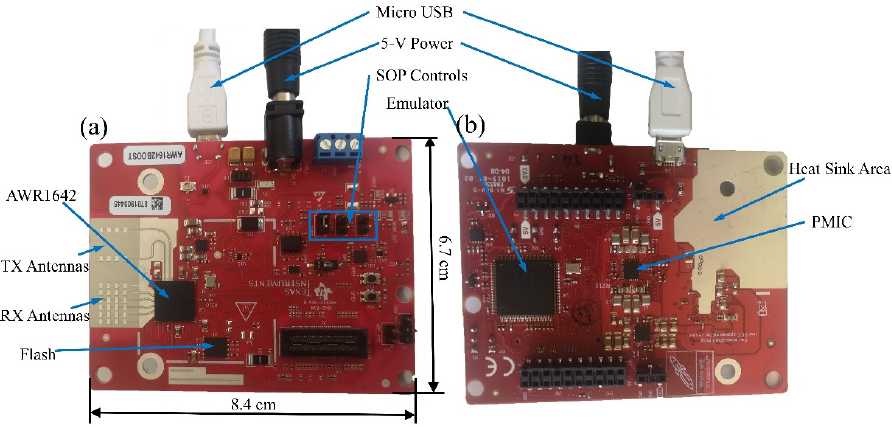
Figure 3. Prototype of the AWR1642 BOOST. ( a ) front view; ( b ) back view.